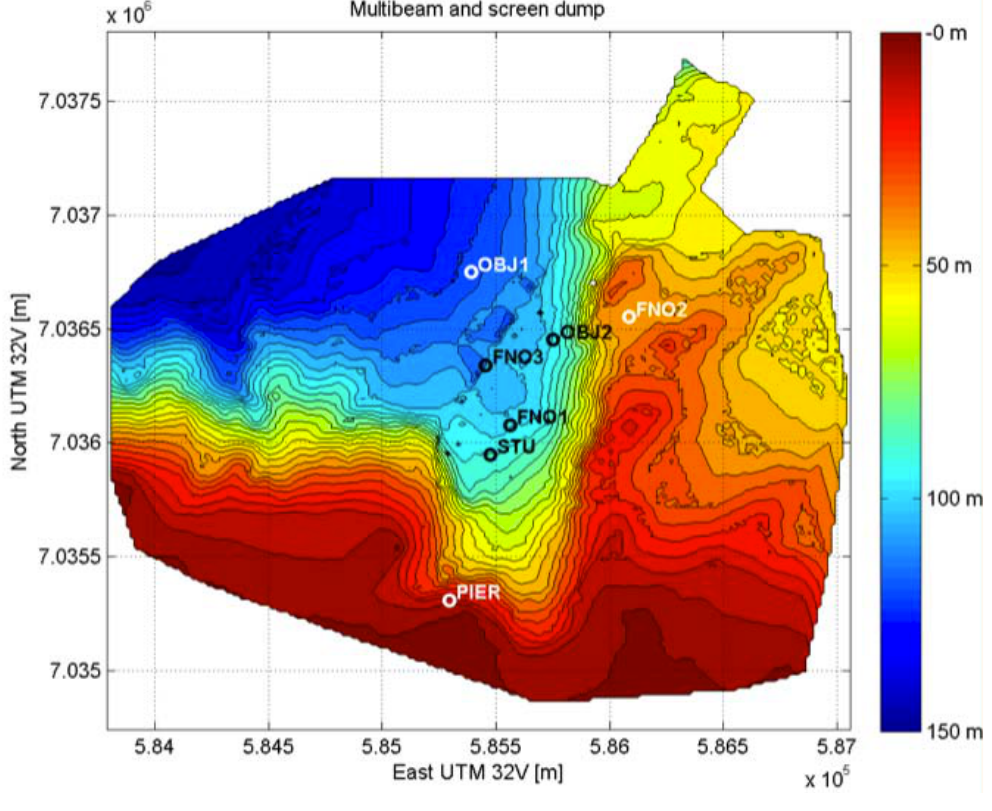
Figure 11. Test area during UAN11 experiment activity. The network topology is superimposed on the bathymetric lines of the area. The STU node represents the UAN base-station; FNO1, FNO2, FNO3 are the three fixed nodes; OBJ1 and OBJ2 indicate the locations of a simulated intruder. PIER represents the UAN land station with the command and